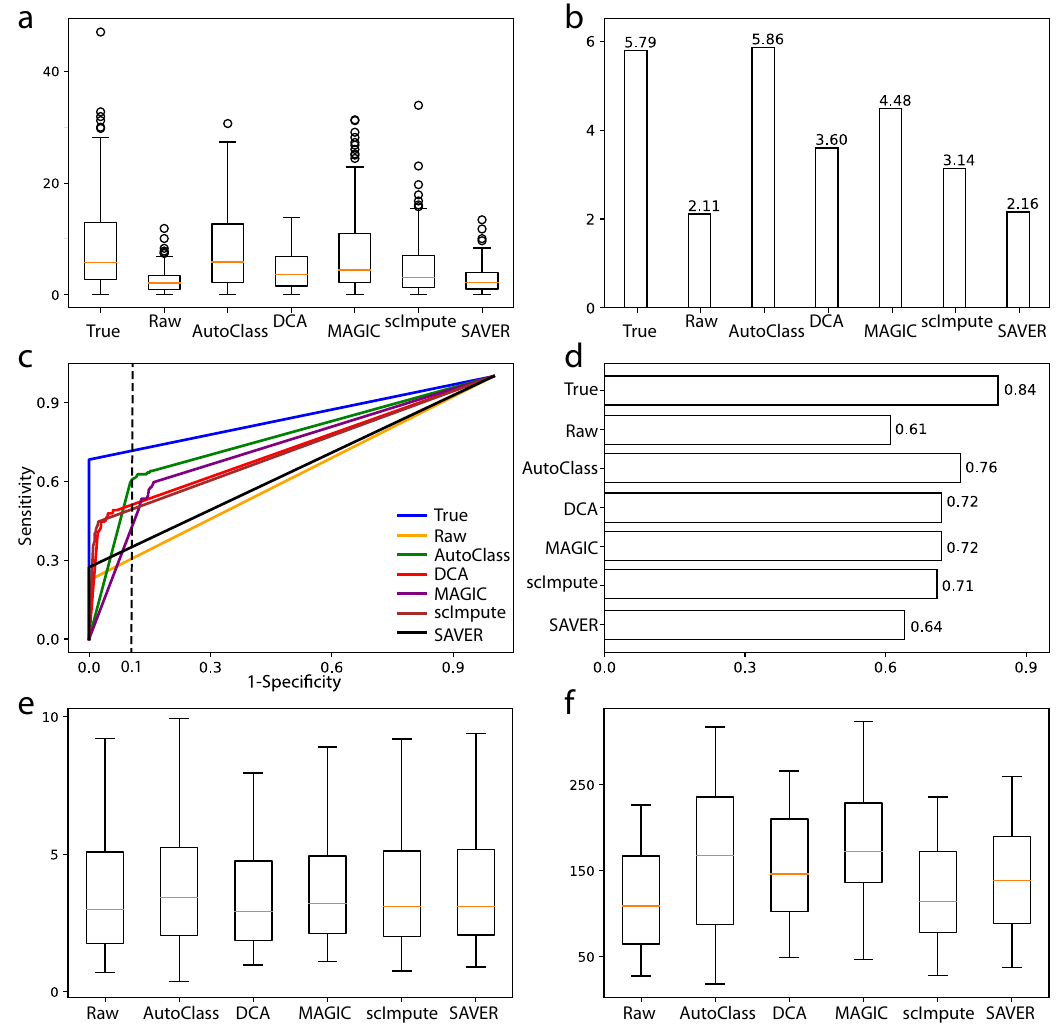
Fig. 3 Differential expression analysis and marker gene analysis. a , b T-statistics and their median values for truly differentially expressed genes in Dataset 8. c , d ROC curves and areas under the ROC curves for Dataset 8. e , f log2 based fold changes and t-statistics of marker genes in the Baron dataset. In a , e , and f , the box represents the interquartile range, the horizontal line in the box is the median, and the whiskers represent 1.5 times the interquartile range, with sample size n = 53 marker